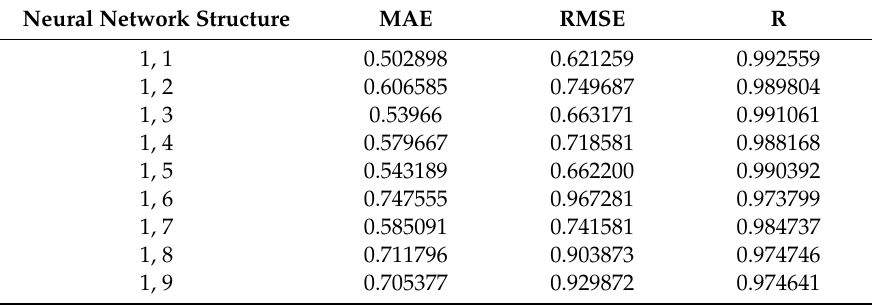
Table 5. Scores of model evaluation indexes with double hidden layers at di ff erent numbers of neurons. Neural Network Structure